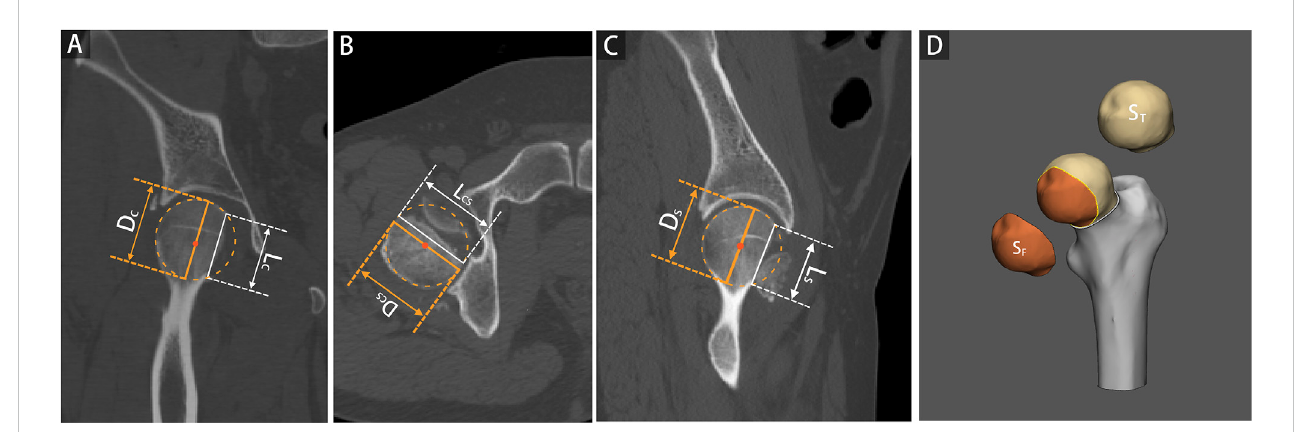
FIGURE 1 2D and 3D parameter measurements based on 2D and 3D injury models of femoral head fractures. The percentage of maximum defect length (PMDL) wasmeasuredas theratiobetweenthemostsigni fi cantresidualdefect length(L)andtheoptimumcircle diameter forthefemoralhead(D), includingcoronal plane[Panel (A) ,PMDL C =L C /D C ],cross-sectional[Panel (B) ,PMDL CS =L CS /D CS ],andsagittalplane[Panel (C) ,PMDL S =L S /D S ].Thepercentageoffracturearea (PFA) was determined as the ratio between the fracture area and the total area of the femoral head [Panel (D) , PFA = S F /S T